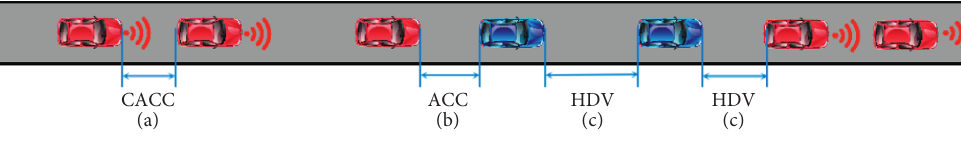
Figure 5: Car following modes of mixed traffic flow. (a) CACC, (b) ACC, and (c) HDV.